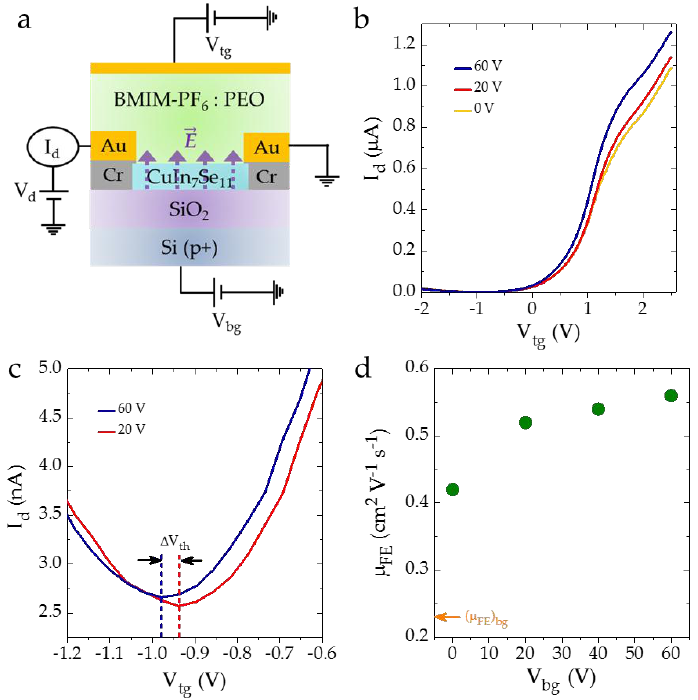
Figure 4. Electronic transport of a CuIn 7 Se 11 FET with a dual gate (Device III): ( a ) Schematic of the FET with a dual (dielectric and ion-gel) gate, arrows indicate the electric field induced in the dielectric gate; ( b ) Transfer characteristics for the forward cycle with the ion-gel gate under di ff erent back gate voltages; ( c ) Change in threshold voltage of the ion-gel gate with the application of back gate voltage; and ( d ) field-e ff ect mobility for the top gate FET under di ff erent back gate voltages. Field-e ff ect mobility due to the ion-gel gate as a function of the back gate voltage is shown